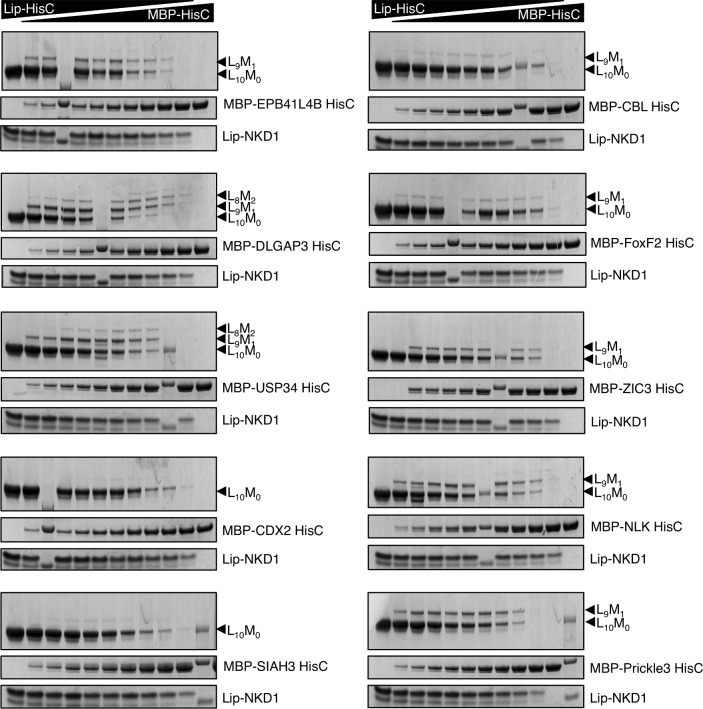
Systematic co-aggregation tests with NKD1-HisC.Co-aggregation assays after mixing purified recombinant Lip-NKD1-HisC and MBP-HisC from various non-nuclear proteins, as indicated on the right (see main Figure 3A, for HisC sequences).